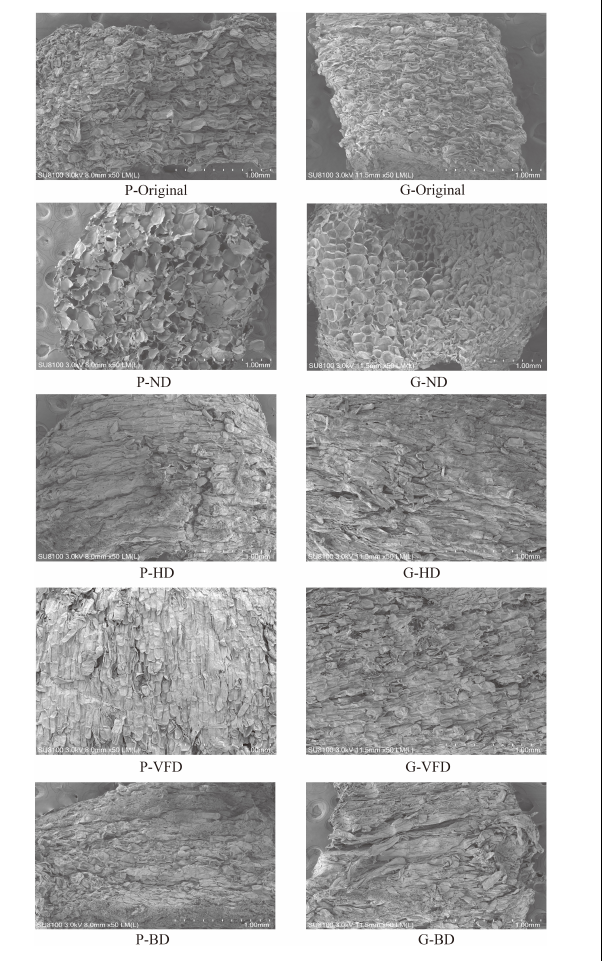
FIGURE 5 | Ultrastructural changes of asparagus-dried products under different drying